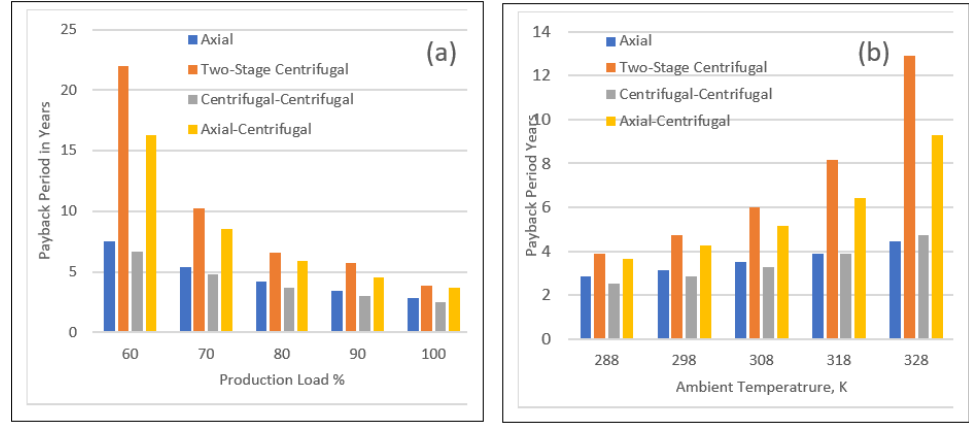
Figure 3. The payback period of each configuration based on selling electricity ( a ) at variant produc- tion load and ( b ) at variant ambient